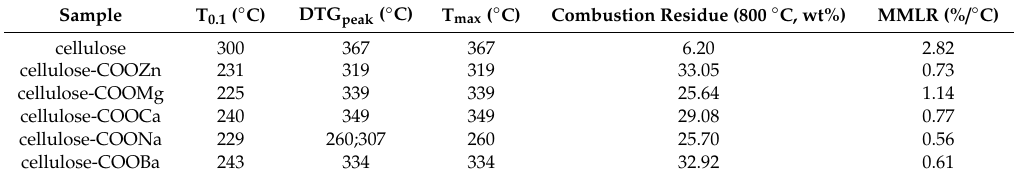
Figure 6. DTG curves of cellulose (a), cellulose-COOZn (b), cellulose-COOMg (c), cellulose-COOCa (d), cellulose-COONa (e), and cellulose-COOBa (f) under N 2. Table 1. The TG and DTG data of cellulose and TEMPO-oxidized cellulose (TOC). Sample